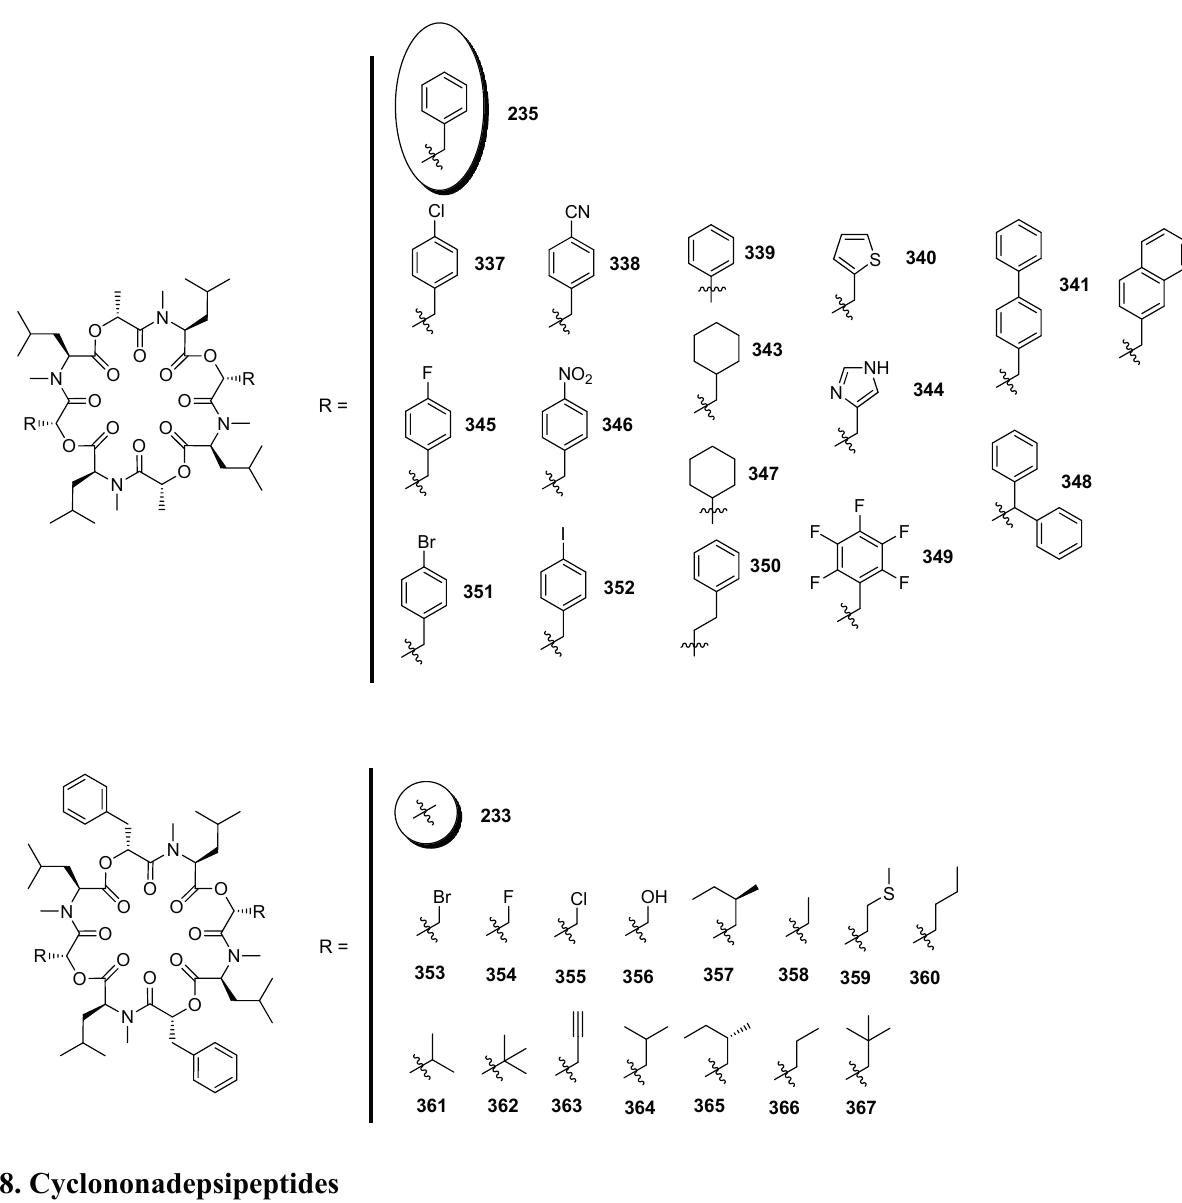
Figure 31. PF1022A derivatives obtained by in vitro